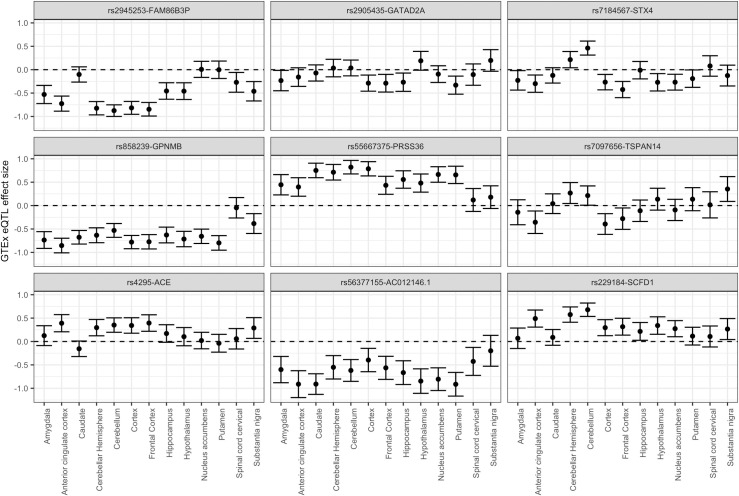
Error bar plot (95% confidence interval around the eQTL effect is displayed) comparing gene expression effects across the 13 brain tissues available in GTEx version 7.9 of our 47 prioritised genes showed statistical evidence of effect size heterogeneity across the brain tissues. STX4 and TSPAN14 genes showed evidence of differing direction of gene expression effect for certain brain tissues.